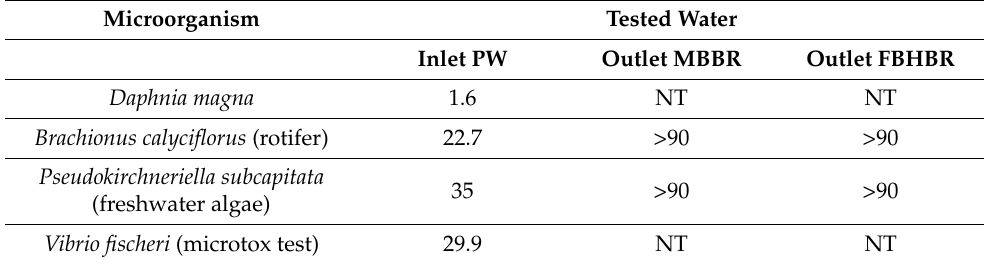
Table 3. Ecotoxicity measurements of inlet water (TDS = 1.5 g · L − 1 ) and outlet water (MBBR and FBHBR) expressed as EC50 (%) (NT refers as Nont-Toxic).